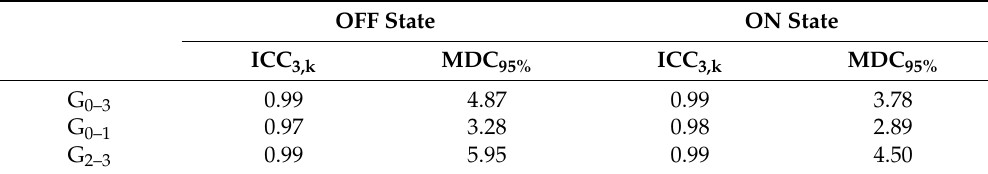
Table 6. ICC values and MDC values of GPQI index for the three subgroups, G 0–3 , G 0–1 and G 2–3 . OFF State ON